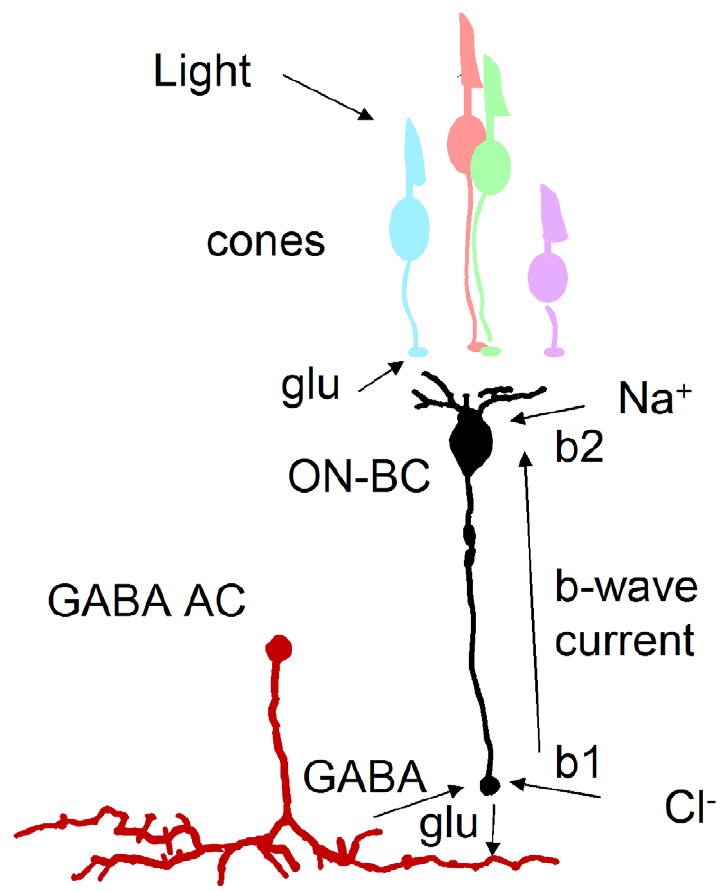
Figure 8. GABA-dependent mechanism for enlarged b-wave. Light leads to a decrease in glutamate (glu) in the cone synaptic cleft. This causes depolarization and release of glutamate from ON-bipolar cells (ON-BC) and consequent GABA release from amacrine cells (AC). The b-wave is a circulation of current around the ON-bipolar cell that is generated, in part, from Na + ions flowing into dendrites and chloride ions (Cl 2 ) flowing through GABA receptors into terminals. An increase in GABA receptor number in celsr3 mutants would increase this current loop, resulting in an enlarged b-wave response.